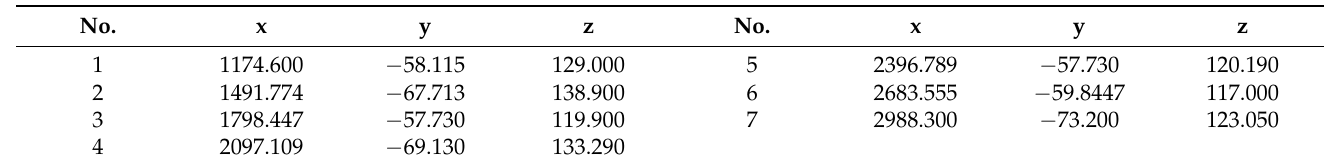
Table 5. The actual coordinates of the centers of mass of the soybean seed particles generated in the simulation.